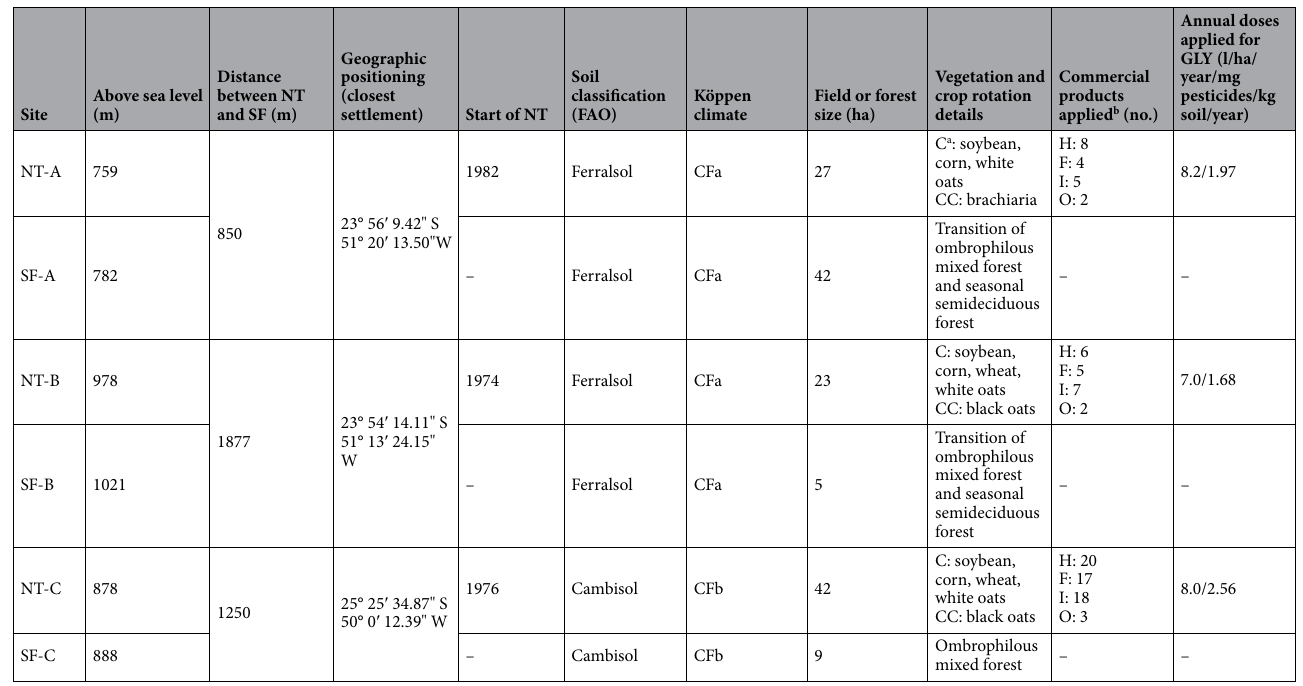
Table 4. Description of the main characteristics of the three agroecosystems. NT no-tillage farming system, SF secondary forest fragment, Soil classification, according to FAO 94 and climate classification, according